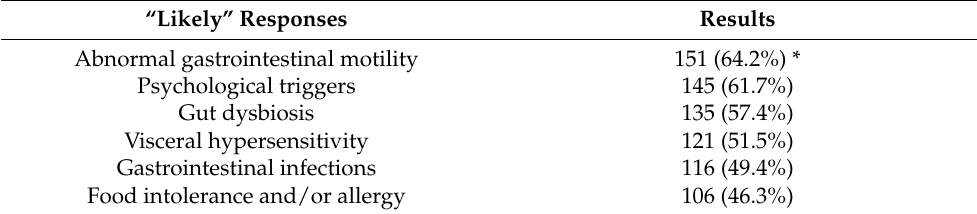
IBS: Irritable bowel syndrome. * p < 0.05 vs. Visceral hypersensitivity, gastrointestinal infections, food intolerance and/or allergy.